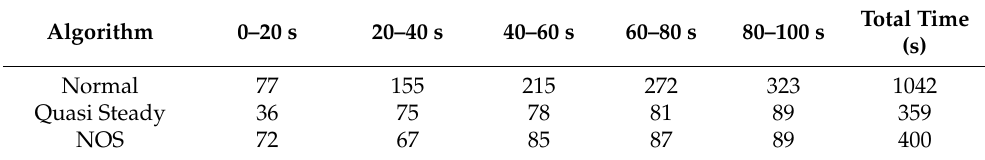
Table 2. Calculation time consumption for each time period.